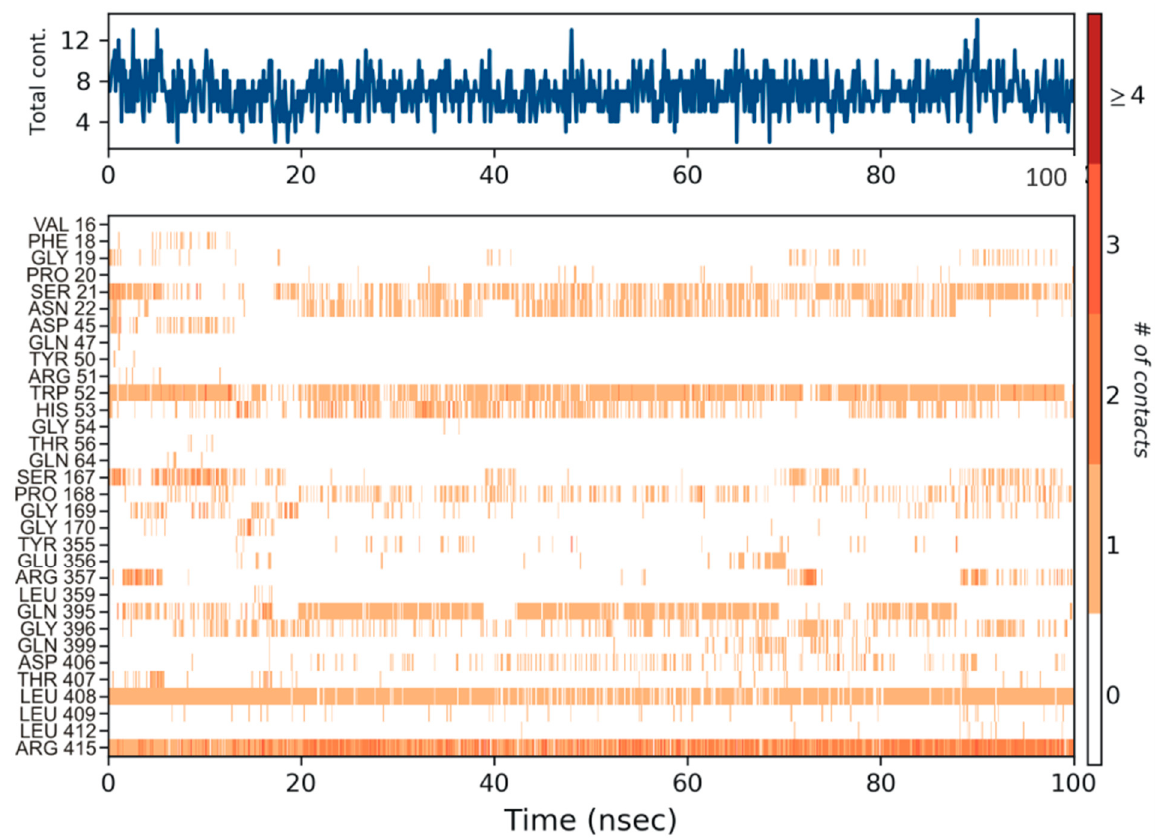
Figure 6. The number of contacts made by the ligand throughout the 100 ns simulation is shown in the top panel (appears in blue). Some residues make more than one specific contact with the ligand, which is represented by a darker shade of orange in the bottom panel, according to the scale to the right of the plot. Arg357 was found to make more than one single contact with the ligand.